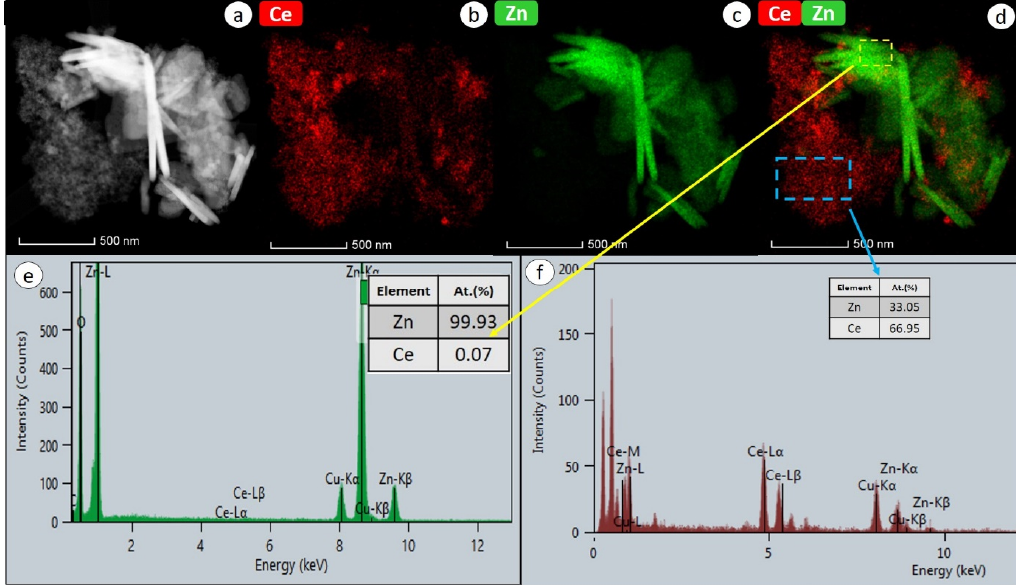
Figure 6. Sample ZnO–Ce 2% ( a ) HAADF-STEM image and the XEDS elemental maps showing the spatial distribution of ( b ) Ce, ( c ) Zn and ( d ) both elements together corresponding to the area displayed in ( a ), ( e , f ) and the XED spectra of the areas marked in ( d ).